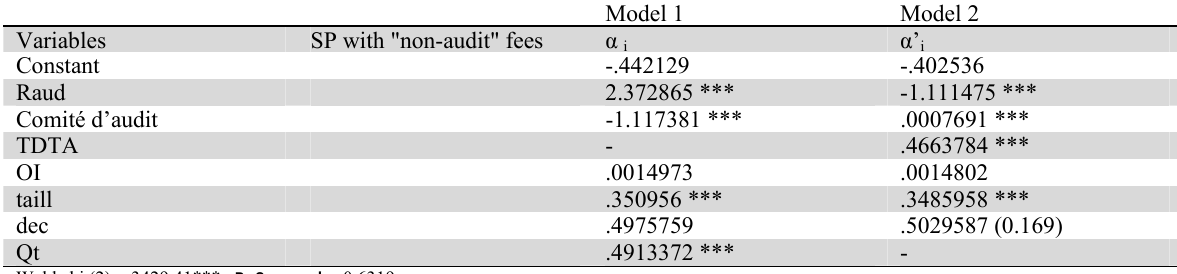
Linear regression of the determinant of non-audit fees